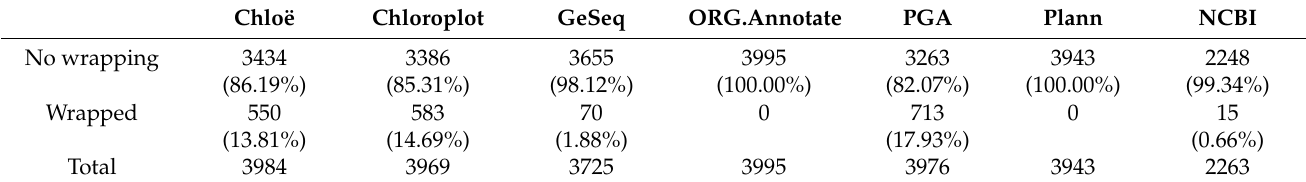
Table 4. Number (and percentage) of complete chloroplast sequences in which the IR regions were identified using six annotation tools (and those annotated in NCBI) classified by the treatment of circularity (no wrapping vs.